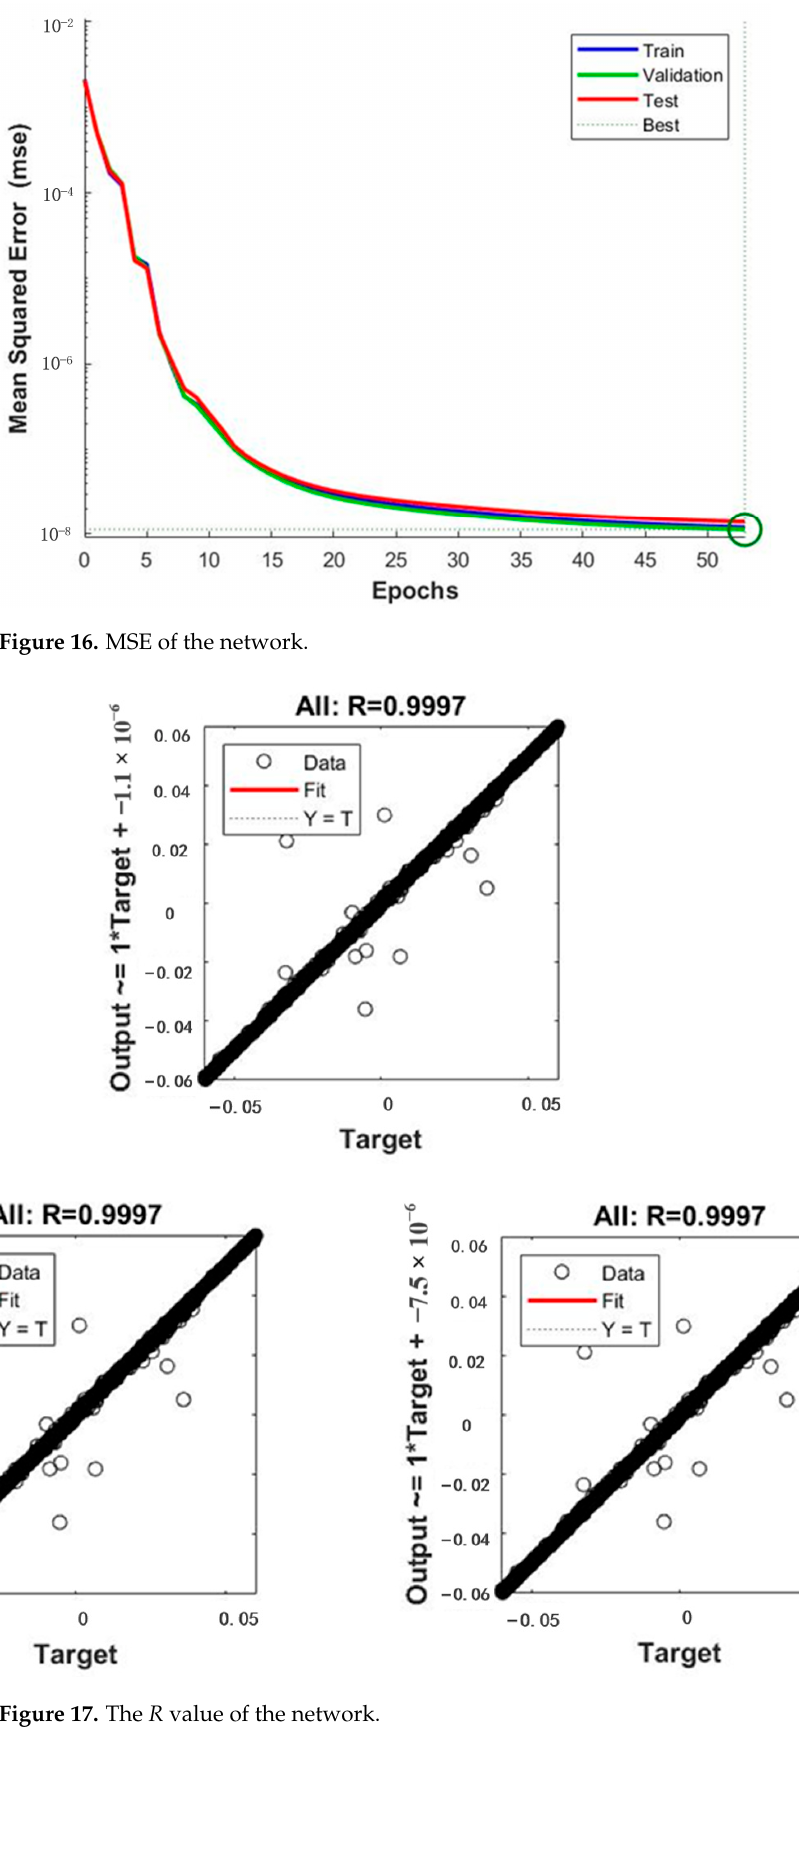
Table 9. Modified finite element model parameters. Parameter